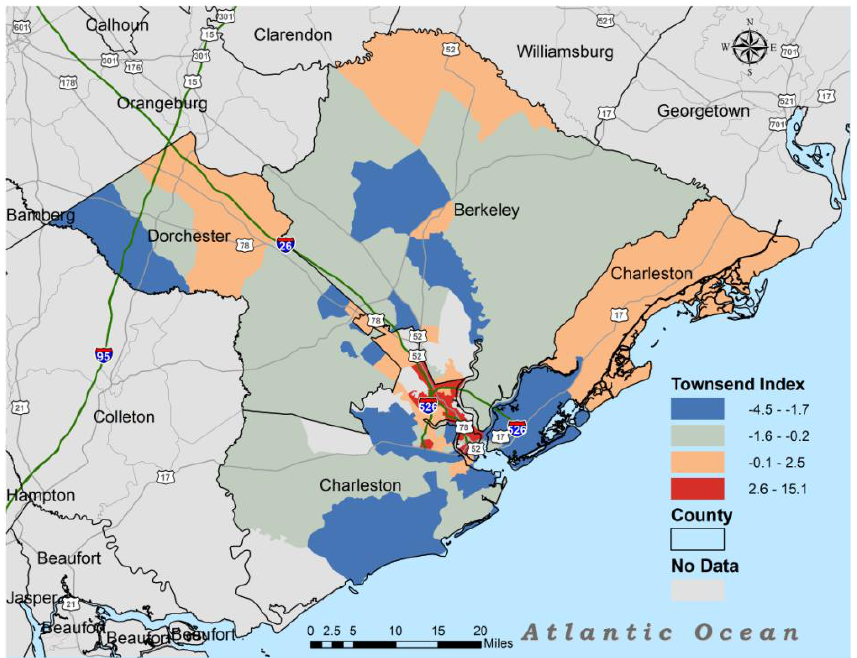
Figure 2. Townsend index for Charleston, South